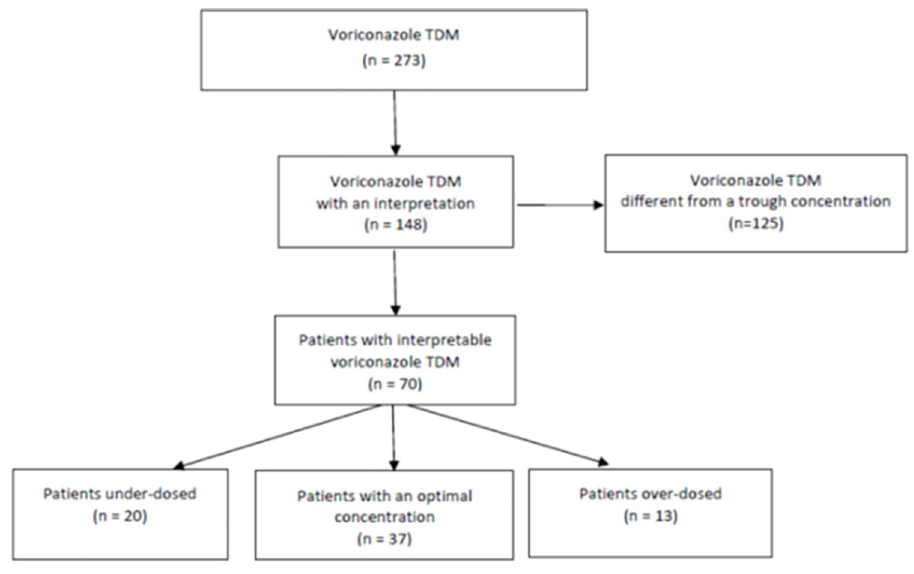
Fig 1. Study flow